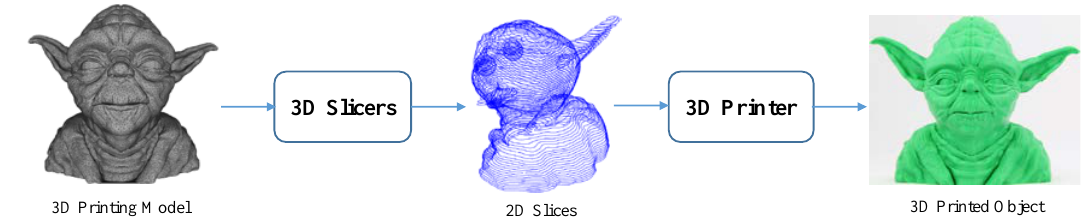
Figure 1. General 3D Printing Process.